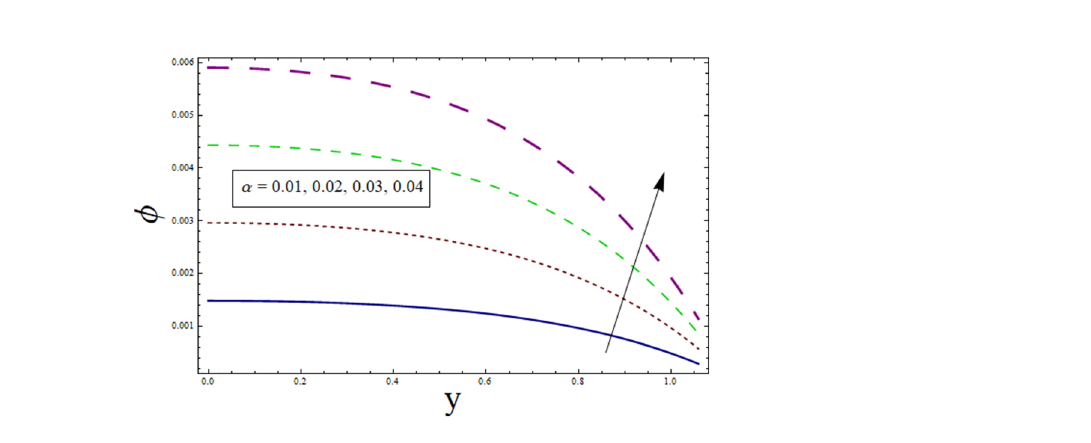
Figure 24. ϕ for α .